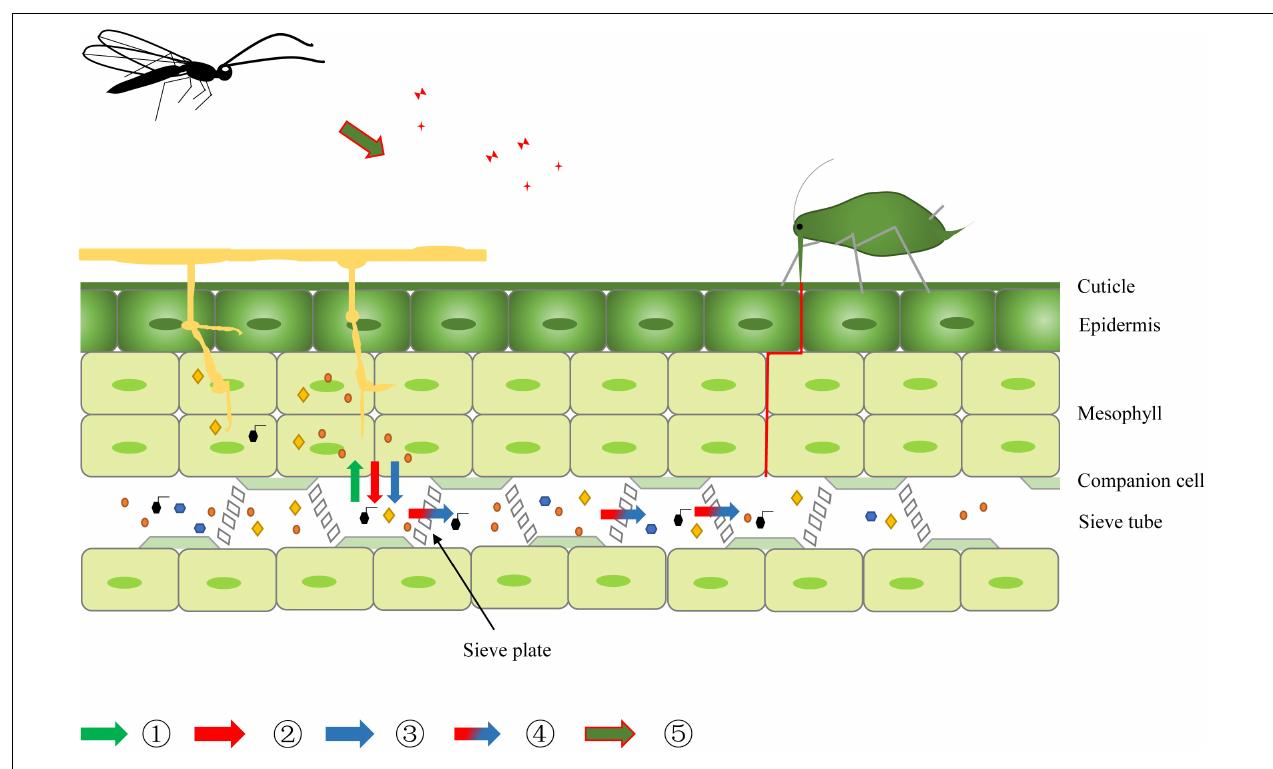
FIGURE 9 | A schematic of aphid-pathogen-plant